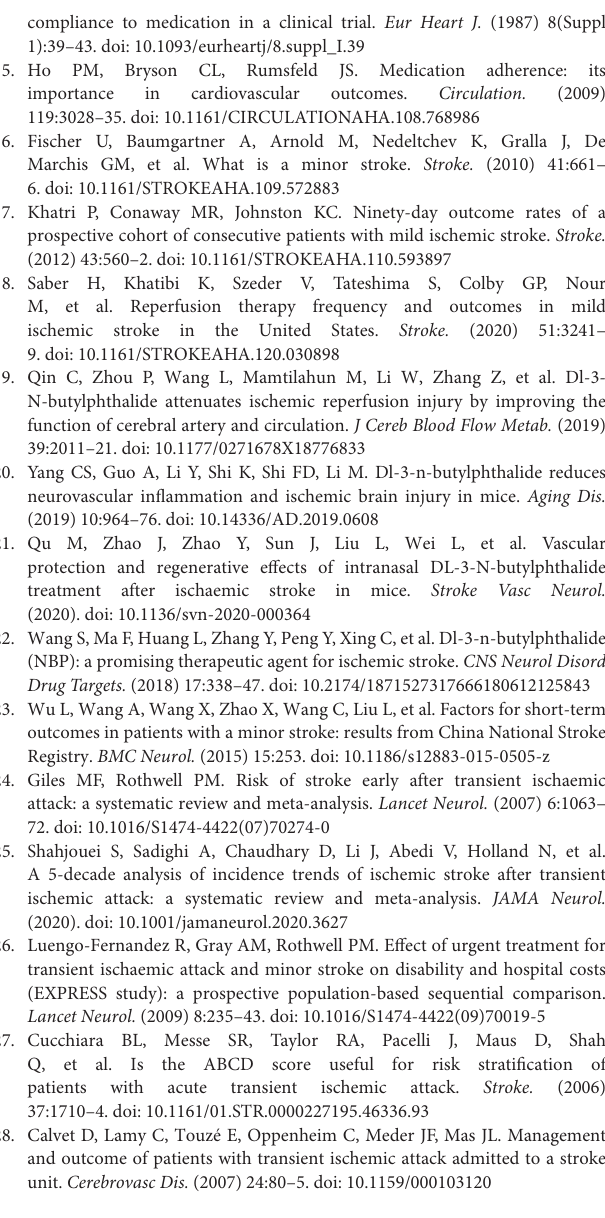
Supplementary Figure 1 | Trial flow